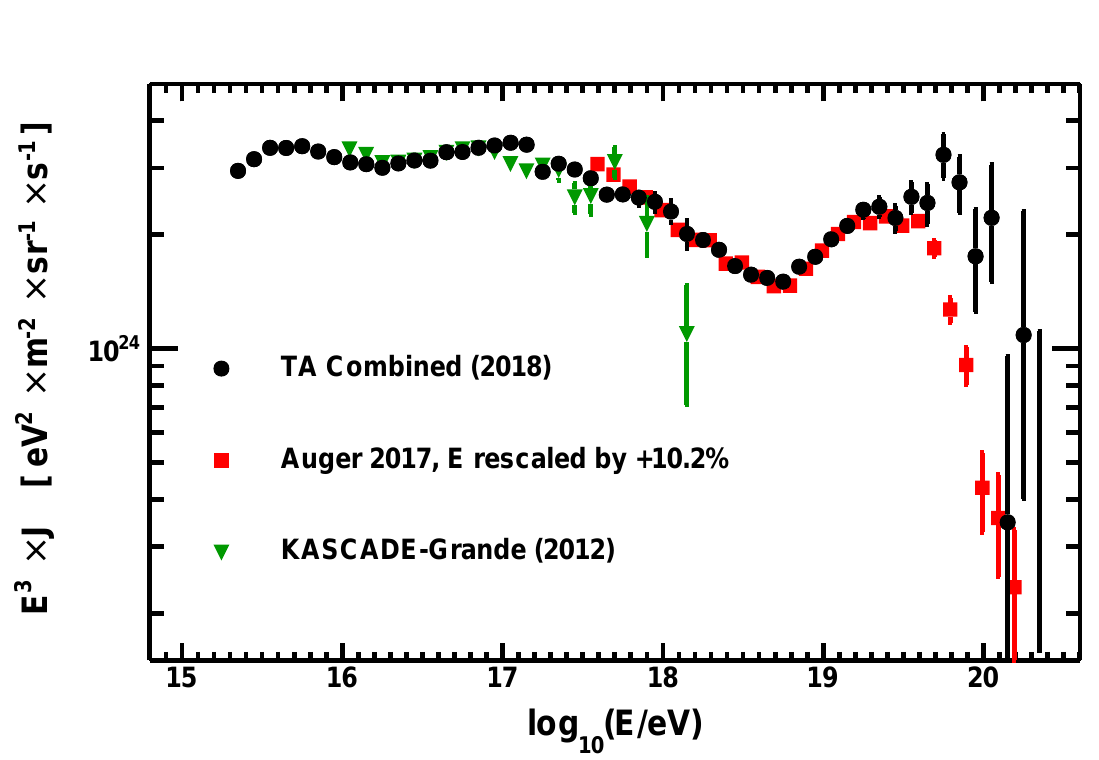
Figure 1. The combined TA spectrum (black points) presented at the UHECR-2018 conference: energy range from 10 15 . 3 to 10 18 . 3 eV is covered by the TALE FD [3], while the TA SD measurement [10] starts at 10 18 . 2 eV and extends to 10 20 eV and higher. Superimposed are the Auger combined spectrum [9], with the Auger energies rescaled by + 10.2% (red squares), and the KASCADE-Grande spectrum [8] (green